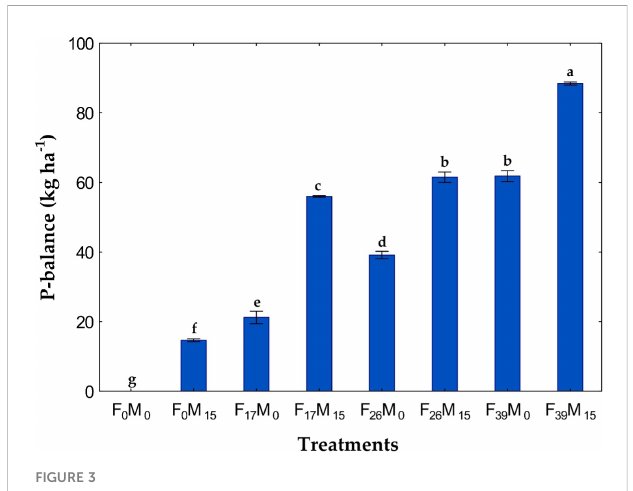
FIGURE 3 P balance (PB) is affected by P application from fertilizer (F) and/or farmyard manure (FYM). Fertilizer was applied at 0, 17, 26, or 39 kg P ha − 1 , and FYM was applied at 0 or 10 T ha − 1 with 0 or 15 kg P ha − 1 , respectively (FYM = 0.15% P). Treatment means with different letters are signi fi cantly different at p< 0.05. Data are shown as means ± SD ( n =